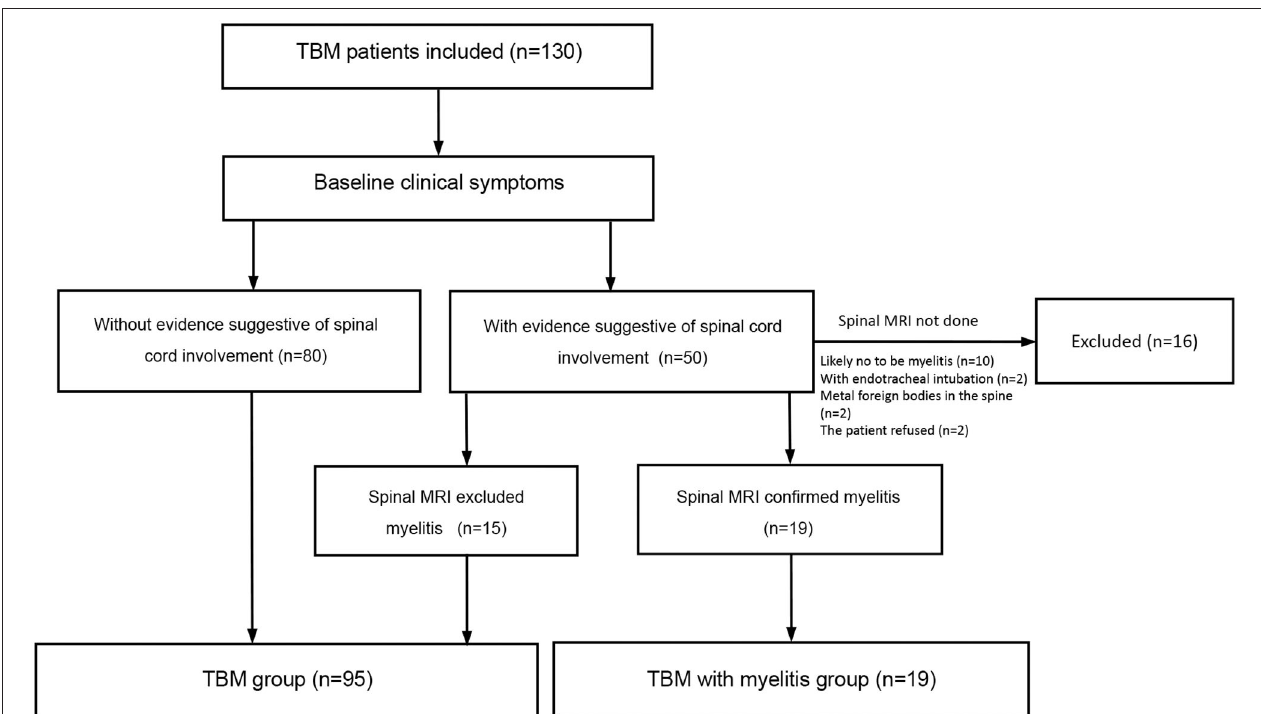
FIGURE 1 | Flow chart of the study. The common signs suggesting spinal cord or spinal nerve root involvement include weakness, pain and paresthesia in the lower limbs or all the four limbs, urinary retention, and constipation.